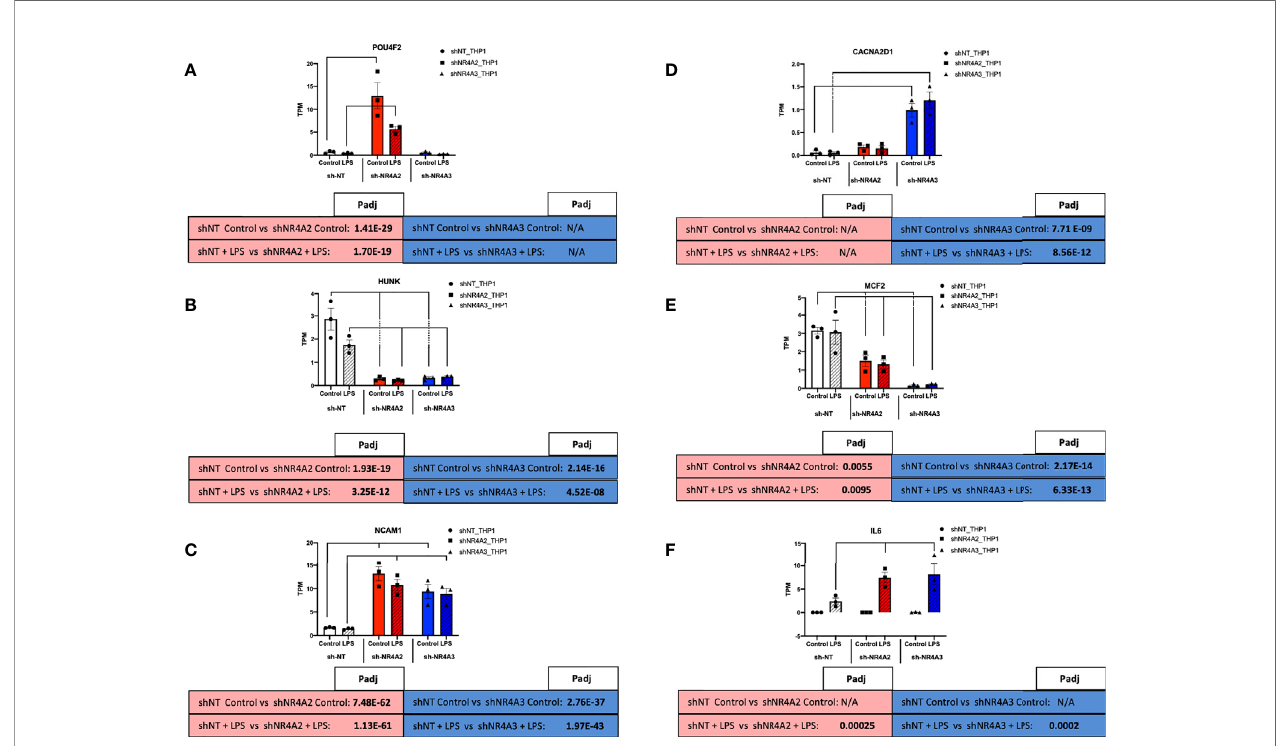
FIGURE 8 | Individual knockdown of NR4A2 and NR4A3 alters the expression of distinct and overlapping genes. RAW TPM values (mean +/- SEM) extracted from RNA-seq for POU4F2 (A) HUNK (B) NCAM1 (C) CACNA2D1 (D) MCF2 (E) and IL-6 (F) in shNT-THP1 cells, shNR4A2-THP1 cells and shNR4A3-THP1 cells in the control (unstimulated state) and following LPS treatment (2.5 m g/ml for 2hrs). N=3 independent experiments. Adjusted p-values (Padj) for speci fi c comparisons are contained in the tables below the TPM data. Statistically signi fi cant Padj are denoted in bold font. Comparisons between shNR4A2 cells and control are denoted in the red boxes, comparisons between the shNR4A3 cells and control are denoted in the blue boxes. Statistically signi fi cant comparisons are further signposted using bars on the TPM